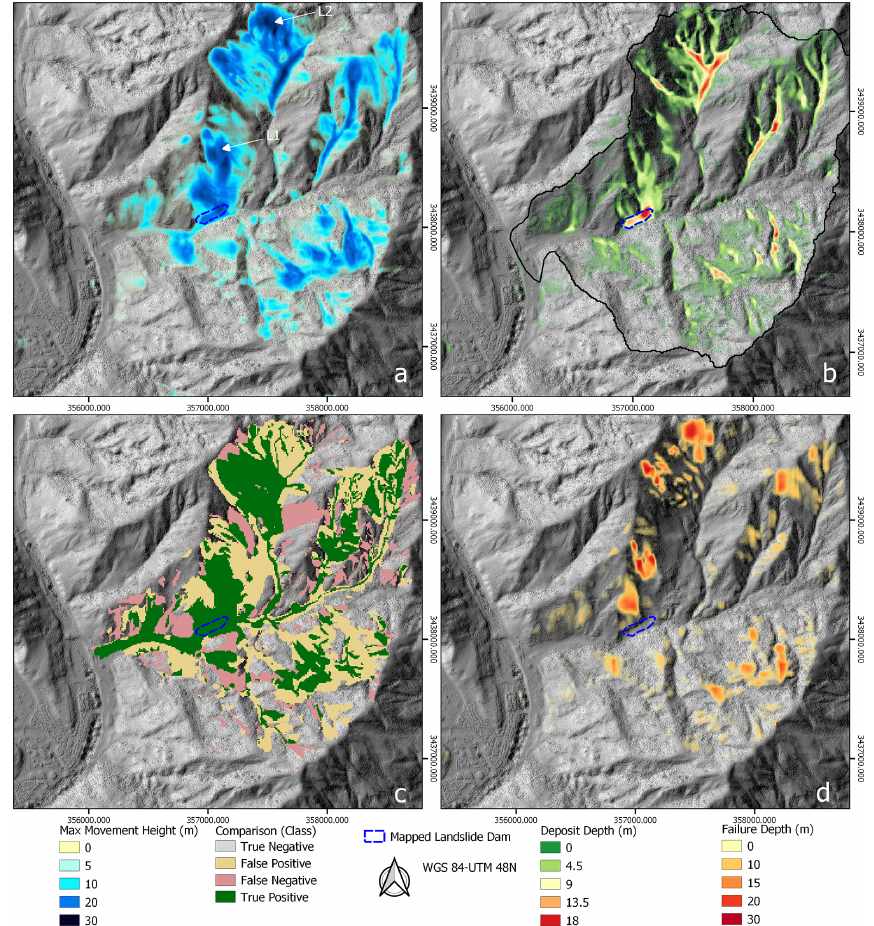
Figure 9. (a) Initiation depth from the slope failure simulation. (b) The simulated final deposit depth of the landslides. Blockage location shown with blue outline (mapped landslide dam). (c) A comparison of modeled landslide runout with the mapped landslide inventory. (d) Maximum landslide runout flow depth. Table 4. Slope stability simulation accuracy and Cohen’s kappa